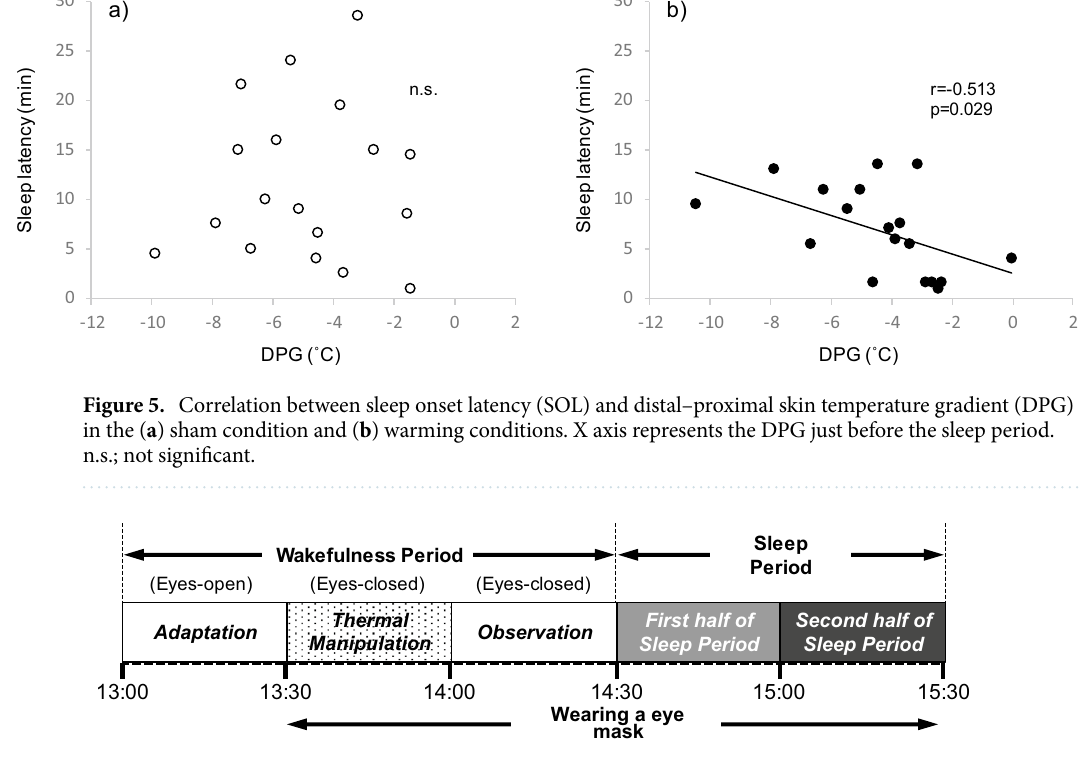
Figure 6. Schedule of the experimental session. In the thermal manipulation period, the periocular skin region temperature was manipulated by applying a warm or sham eye mask at 13:30. Subjects were instructed to maintain wakefulness with their eyes closed between the thermal manipulation and observation